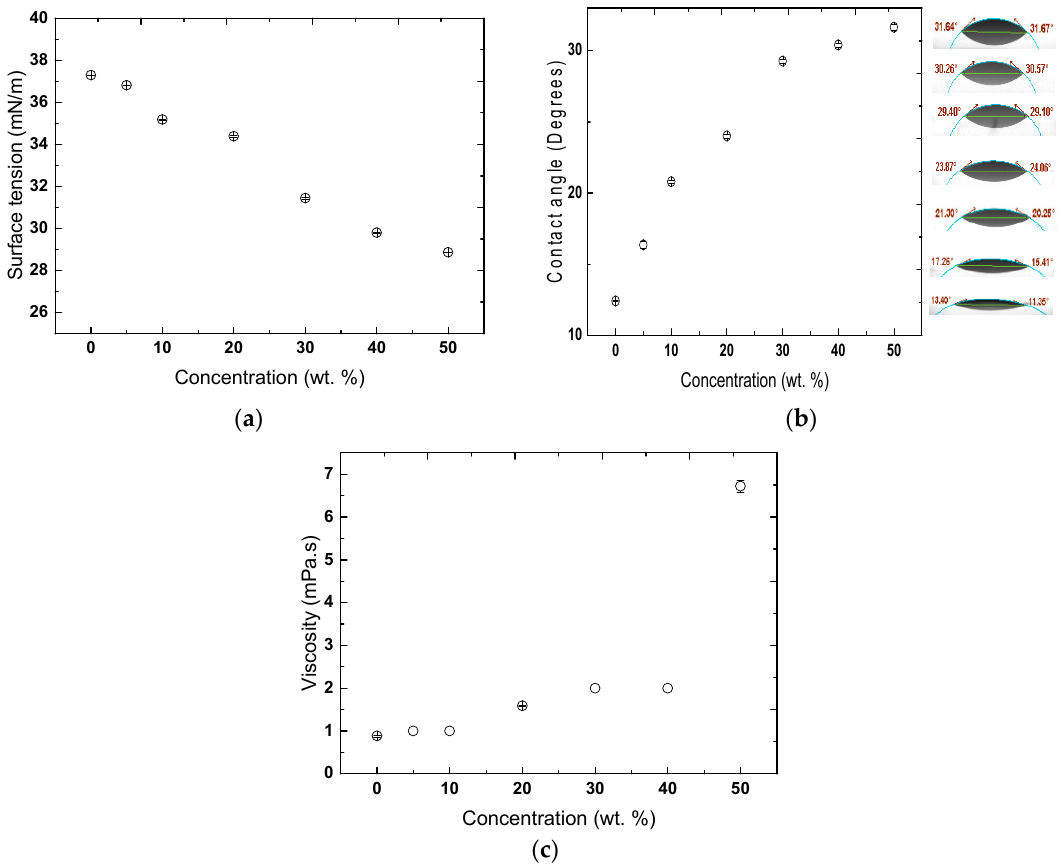
Figure 3. Variation of the physical properties of the mixed halide perovskite solution (MAPbI 3 − x Cl x in DMF) versus solution concentration in wt.% of solute in solution. ( a ) liquid–air surface tension; ( b )